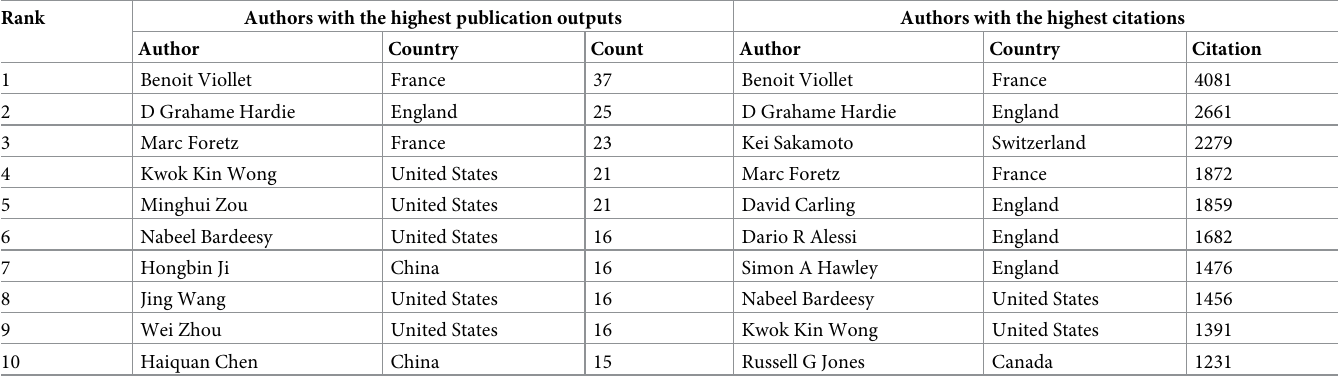
Table 3. Top 10 authors in LKB1 research, 2000 to 2021.